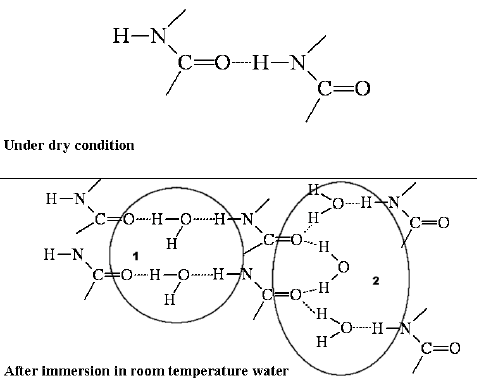
Figure 12. Effects of water on the hydrogen bonding in PUs: ( 1 ) weakly bonded water; ( 2 ) firmly bonded water.